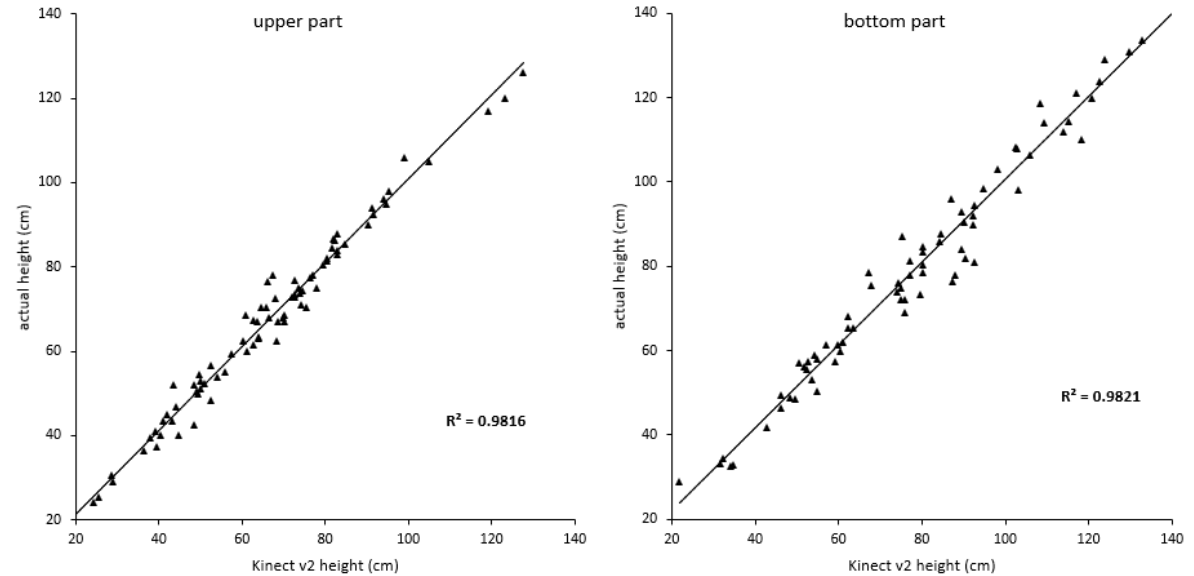
Figure 3. Regression analyses comparing actual data (measured height as ground truth) versus Kinect v2 heights for the upper part and bottom for all the 83 sampled olive trees. Dataset faithful at 0.05 significance level.